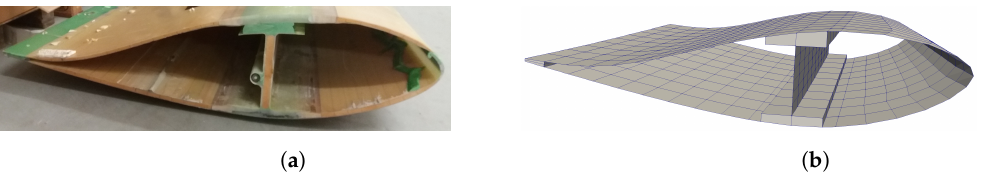
Figure 12. Comparison of as-built structure and finite element model. ( a ) Cross-section of the wind turbine rotor blade after cutting. ( b ) Cross-section of the wind turbine blade in the finite element